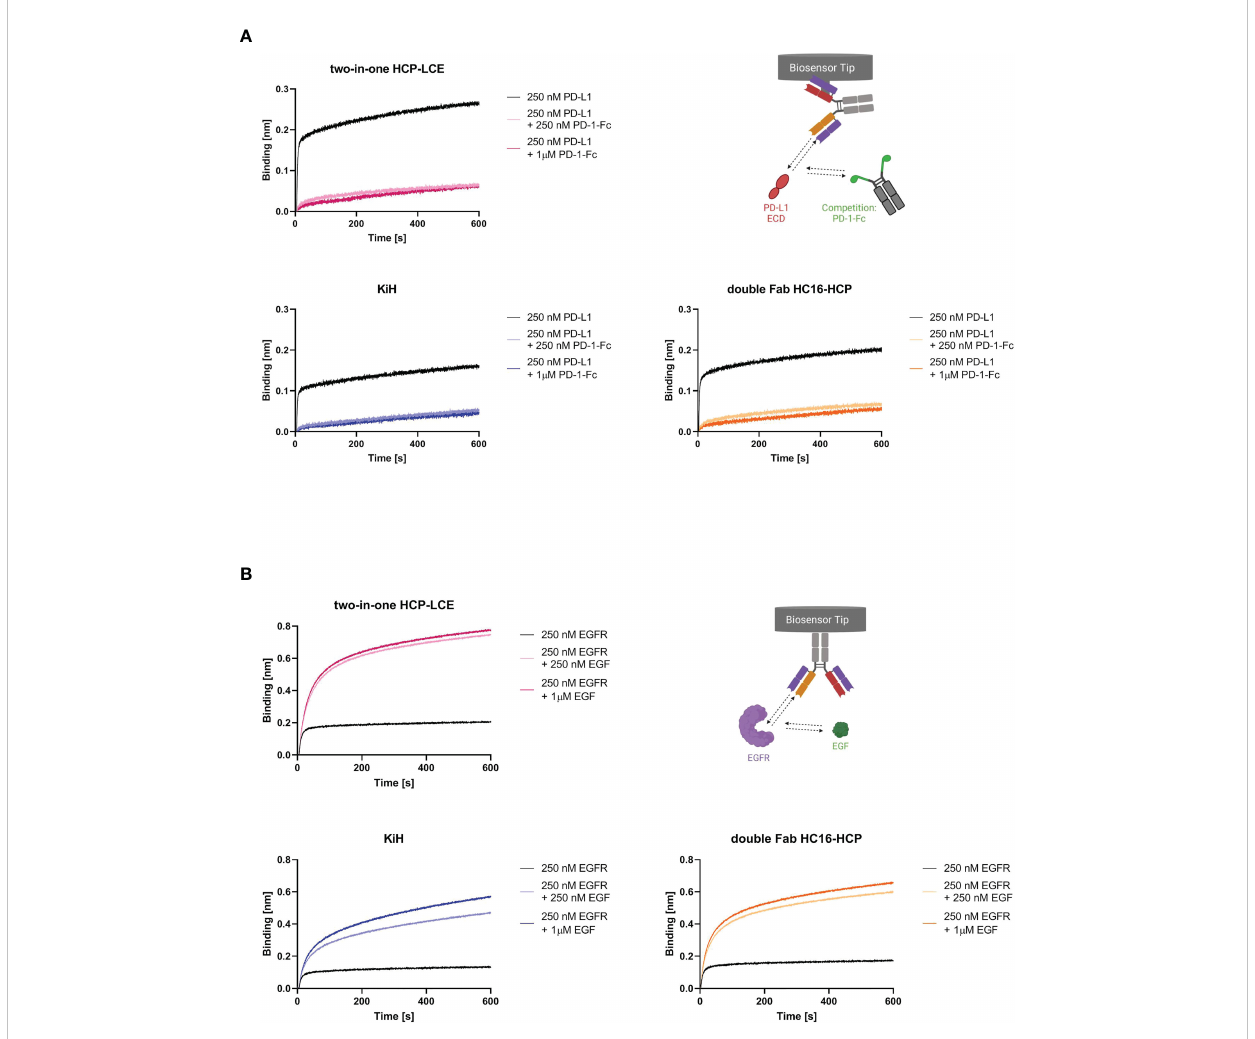
FIGURE 3 EGF and PD-1 competition assay by BLI. (A) BLI-assisted PD-1 competition assay. The two-in-one antibody HCP-LCE (pink), the KiH variant (blue) and the double Fab variant HC16-HCP (orange) were loaded onto FAB2G biosensors and subsequently associated to PD-L1 preincubated with varying PD-1 concentrations. Binding of the antibody variants to PD-L1 at different PD-1 concentrations reveal dose-dependent binding. (B) BLI- assisted EGF competition assay. The two-in-one antibody HCP-LCE (pink), the KiH variant (blue) and the double Fab variant HC16-HCP